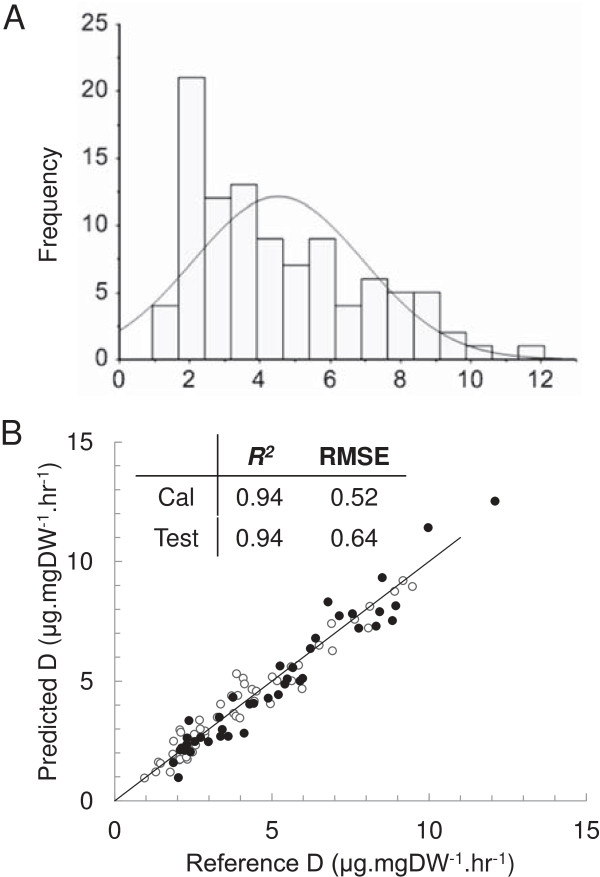
FTIR prediction of cell wall digestibility. (A) Distribution of cell wall digestibility (μg.mgDW-1.h-1) from a diverse collection of S. bicolor ecotypes grown under a range of different conditions and harvested at varying developmental stages. A fitted normal distribution has been overlaid. (B) PLS prediction of cell wall digestibility (D; μg.mgDW-1.h-1) in an independent test set. Predictions are plotted against the known reference values for each sample. Calibration samples (○) and independent validation samples (•) were overlaid on a target line (y = x). The coefficient of determination (R2) and root mean square error (RMSE) for each sample set are inset. DW, dry weight; FTIR, Fourier transform infrared; PLS, partial least squares; RMSE, root mean squared error.